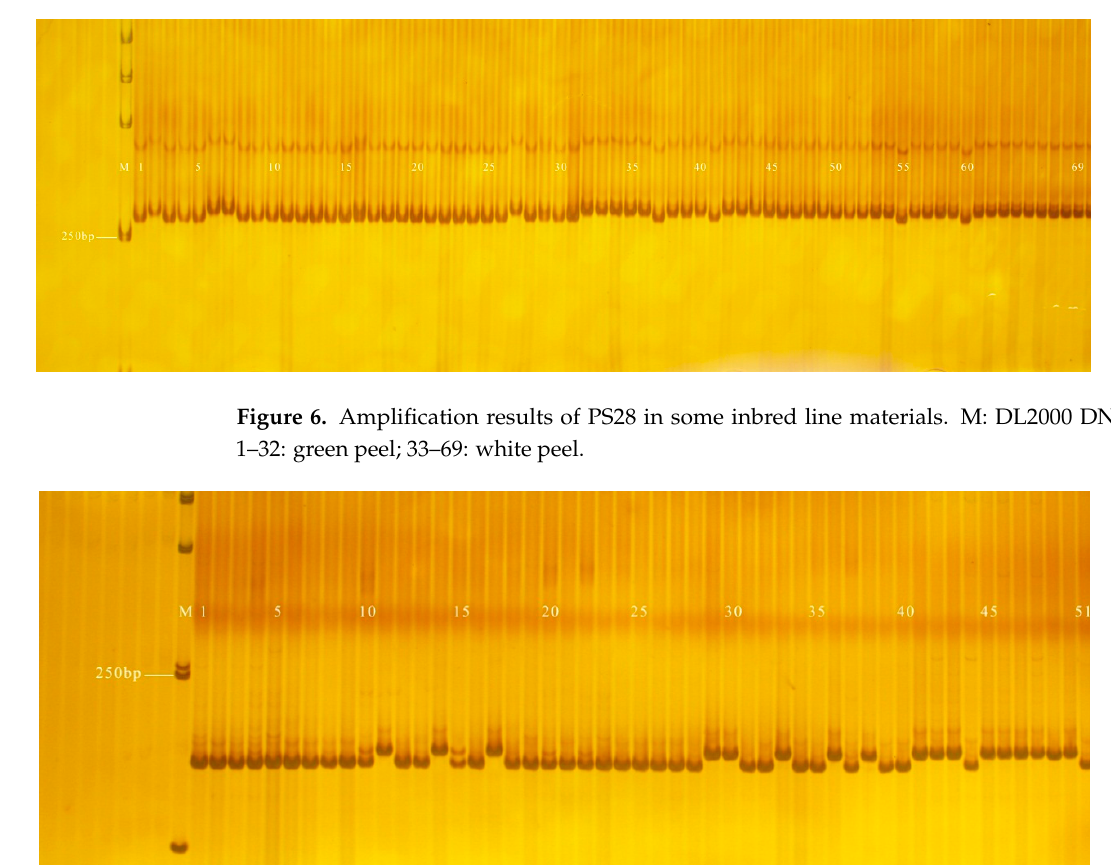
Figure 7. Amplification results of PS30 in some inbred line materials. M: DL2000 DNA Marker; 1–